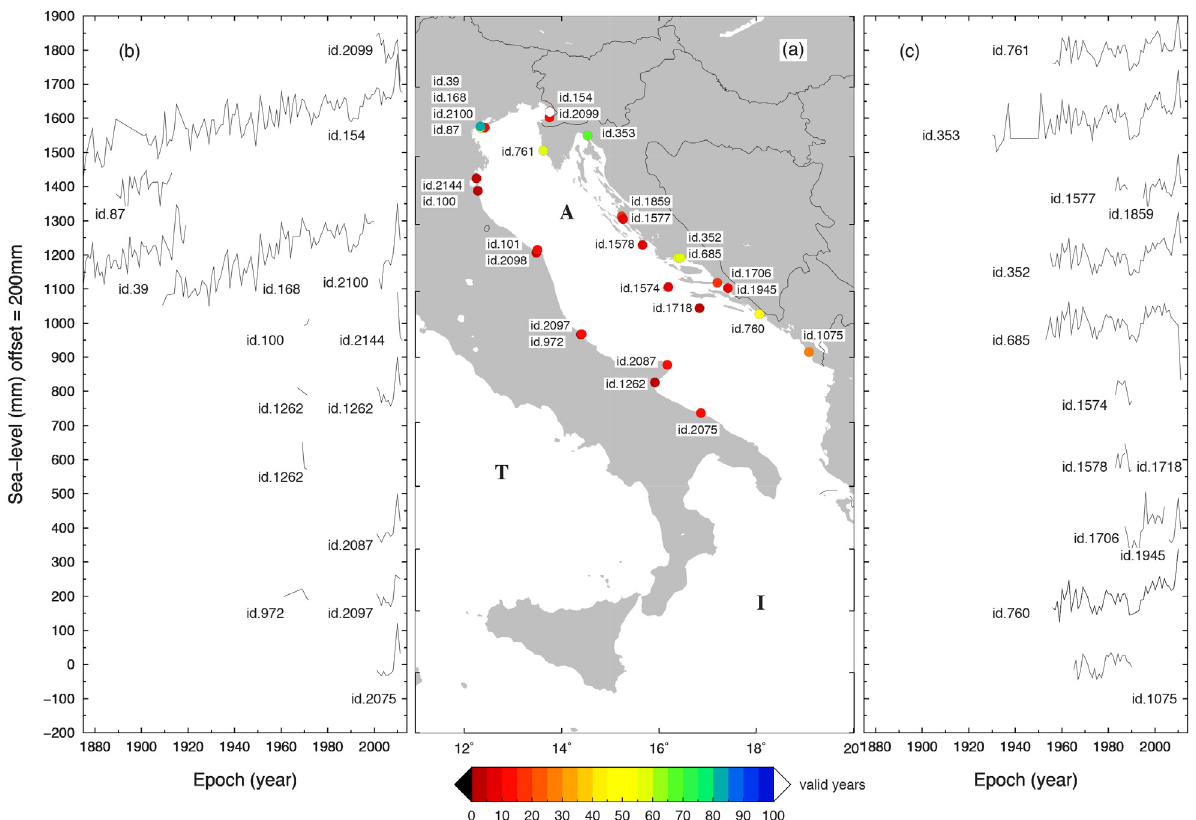
Figure 1. (a) Location of the RLR PSMSL tide gauges in the Adriatic Sea (Ids are also indicated). Letters A, I and T denote the Adriatic, the Ionian and the Tyrrhenian Seas, respectively. The number of valid years N is key-coded by the color palette. (b) and (c) show the annual val time series available at each station (see Table 1). The time series are shifted by 200 mm to facilitate